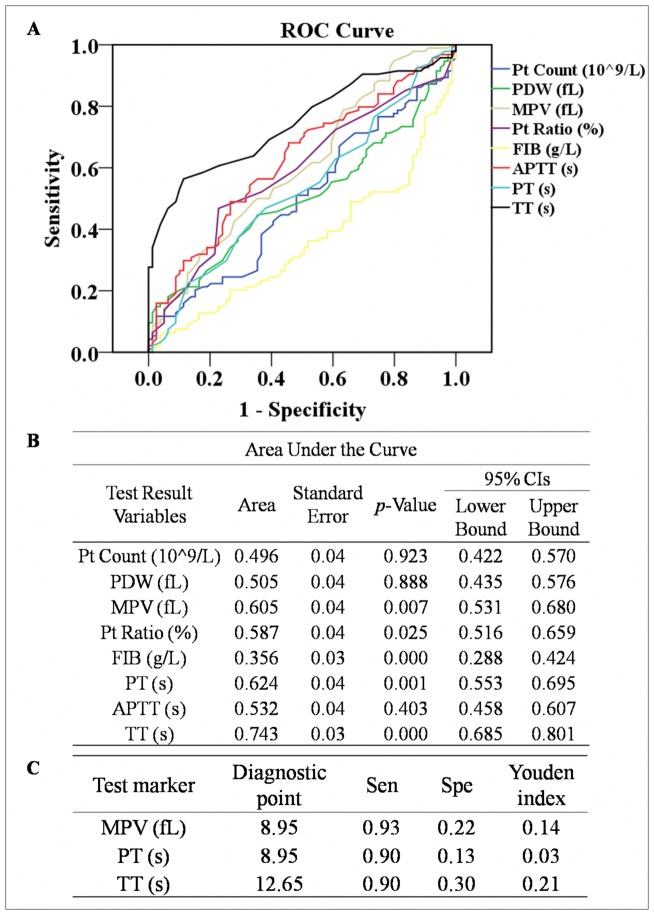
ROC curves for APTT, FIB, TT, PT, Pt Count, PDW, MPV and Pt Ratio in early pregnancy to analyze the optimal diagnostic points for predicting preeclampsia in women.